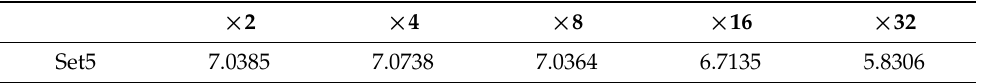
Table 1. The average information entropy of Set5 dataset down-sampled to different levels of images. (Unit: bits/pixel).